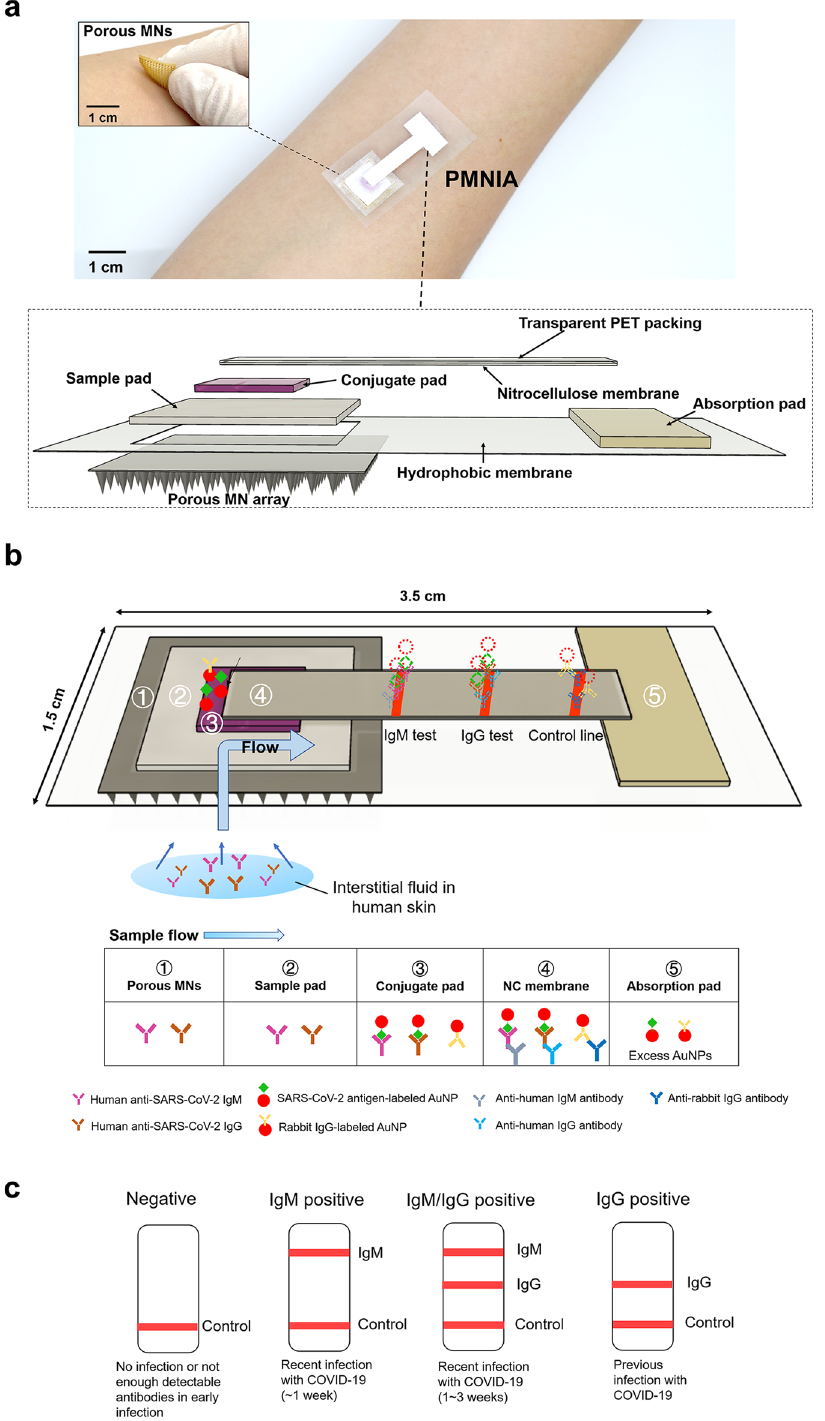
Figure 1. Design of PMNIA for COVID-19 detection. ( a ) Photograph of a structural overview of the detection device and a magnified view of the device comprising the porous MN array and components of the paper- based immunochromatographic biosensor. Inset image shows the porous MN array with a flexible substrate. ( b ) Schematic diagram of the PMNIA principle for simultaneous detection of anti-SARS-CoV-2 IgM/IgG. ( c ) Illustration of the interpretation of the different detection results using